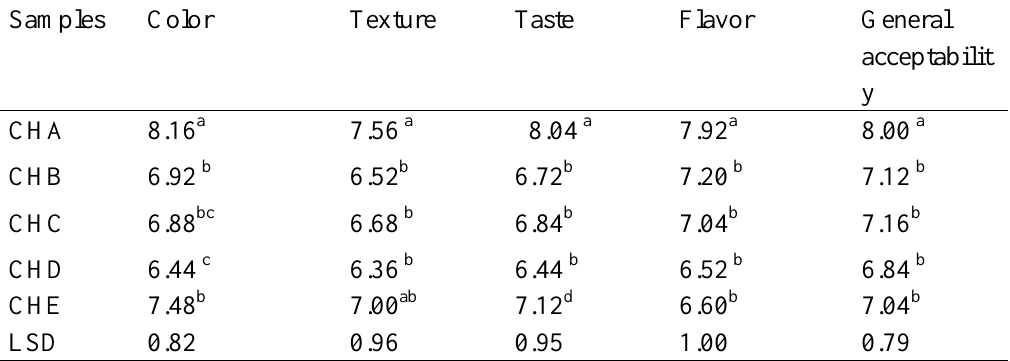
Means with the same superscript in the same column are not significantly different